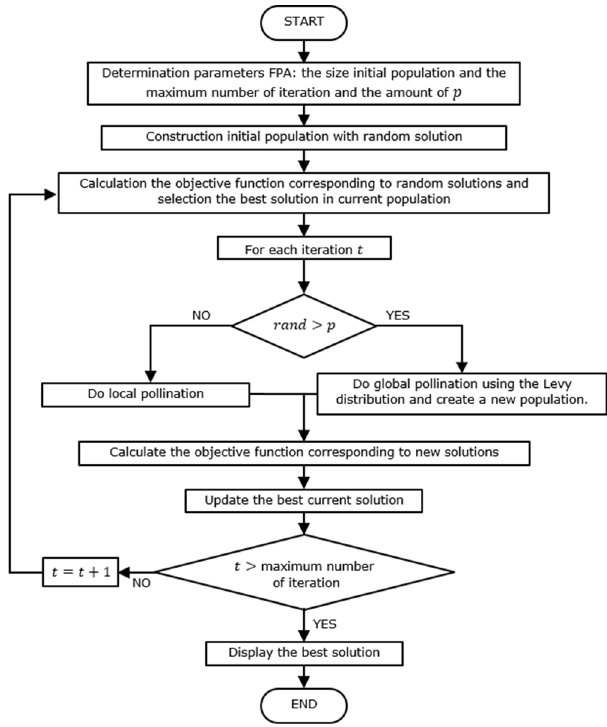
Figure 5. Flower Pollination Algorithm Flowchart.